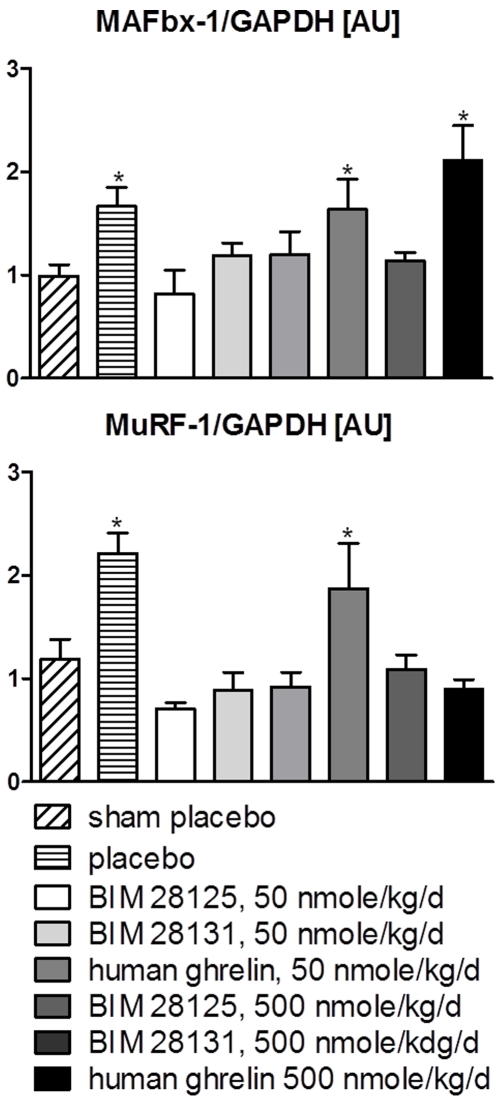
Induction of E-3 ubiquitin ligases MuRF-1 and MAFbx in gastrocnemius muscle by myocardial infarction.Low dose of the compounds reduced MuRF-1 and MAFbx expression. Treatment with high dose BIM-28131 and human ghrelin reduced MuRF-1 (A) and only treatment with high does BIM-28131 reduced MAFbx (B). *: p<0.05 vs sham.